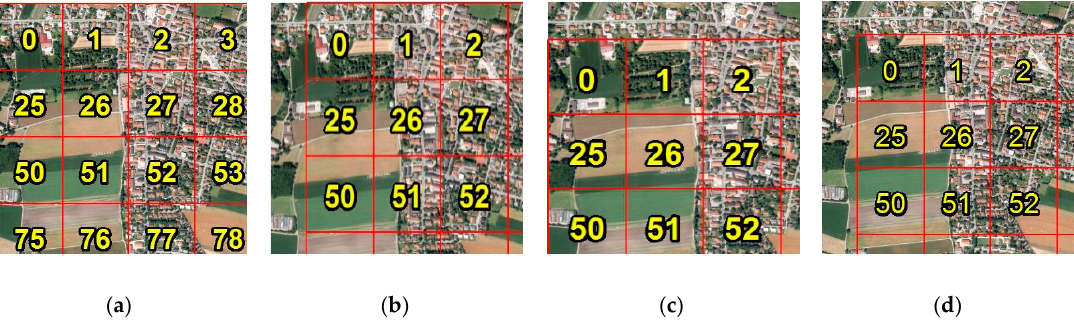
Figure 6. Different slicing methods (i.e., different dx, dy starting point) for the same area: ( a ) dx = dy = 0 m; ( b ) dx = 200 m, dy = 0 m; ( c ) dx = 0 m, dy = 200 m; ( d ) dx = dy = 200 m.